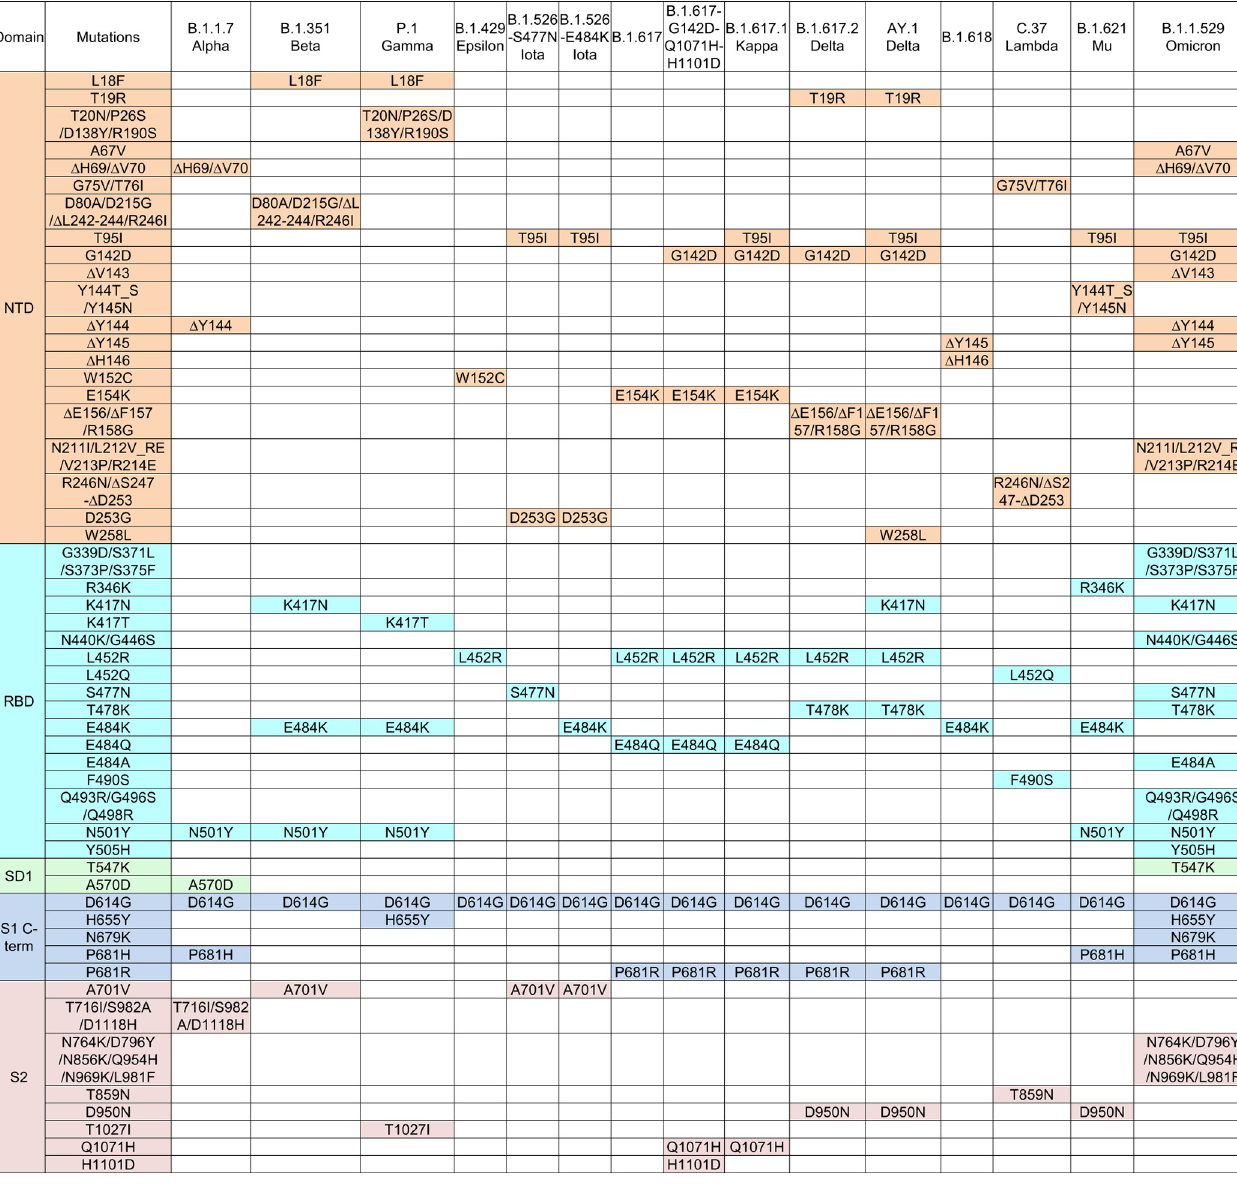
Fig 2. Overview of spike ectodomain mutations in variants of SARS-CoV-2. Mutations in the ectodomain of the spike protein from variants B.1.1.7, B.1.351, P.1, B.1.429, B.1.526 (2 sequences), B.1.617 (2 sequences), B.1.617.1, B.1.617.2, AY.1, B.1.618, C.37, B.1.621, and B.1.1.529 are labeled with a colored box. � Note: L5F is not included in the B.1.526 sequences because the constructs in this study started from Q14. [19]. The construct design comprised three segments. The first segment was an N-terminal purification tag denoted as ‘scFc3C’, which contained a modified ‘knob-in-hole’ single chain constant portion of an antibody (scFc) followed by a cleavage site (LEVLFQGP) for the highly specific human rhinovirus 3C (HRV3C) protease [26]. This ‘knob-in-hole’ feature avoids for- mation of intermolecular Fc dimer and is defined by a protruding tyrosine in the N-terminal- half of the Fc-interface (T366Y), a recessed threonine in the C-terminal-half of the Fc-interface (Y407T), in conjunction with an insert of a 20-residue-linker (GGGGS) (Kabat antibody resi- 4 due numbering [27]). The second segment was the sequence of interest from SARS-CoV-2